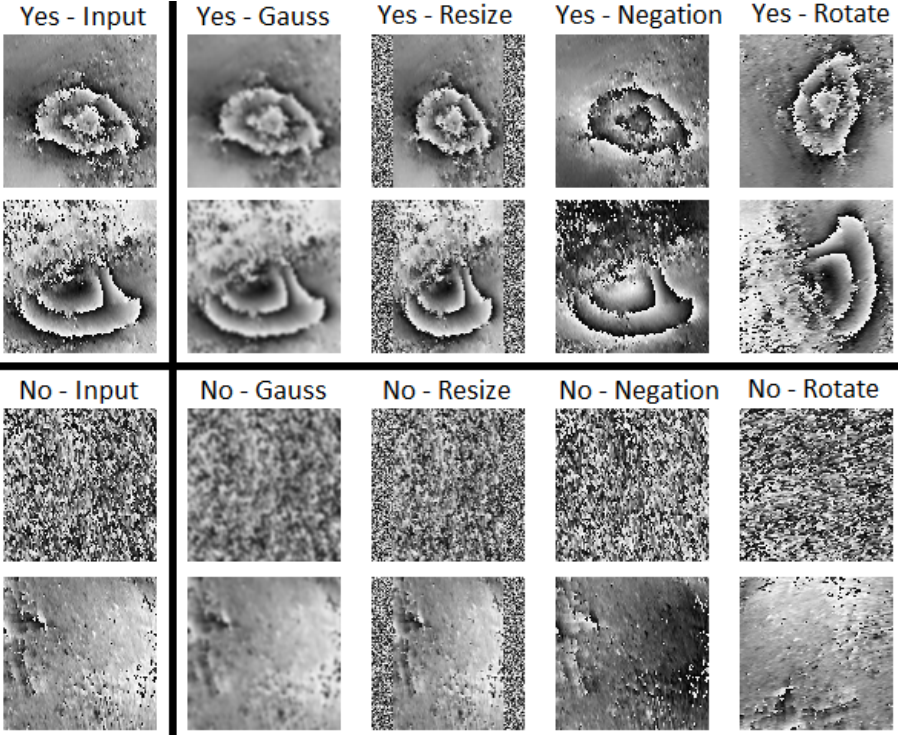
Figure 4. Images comprising the test set after data